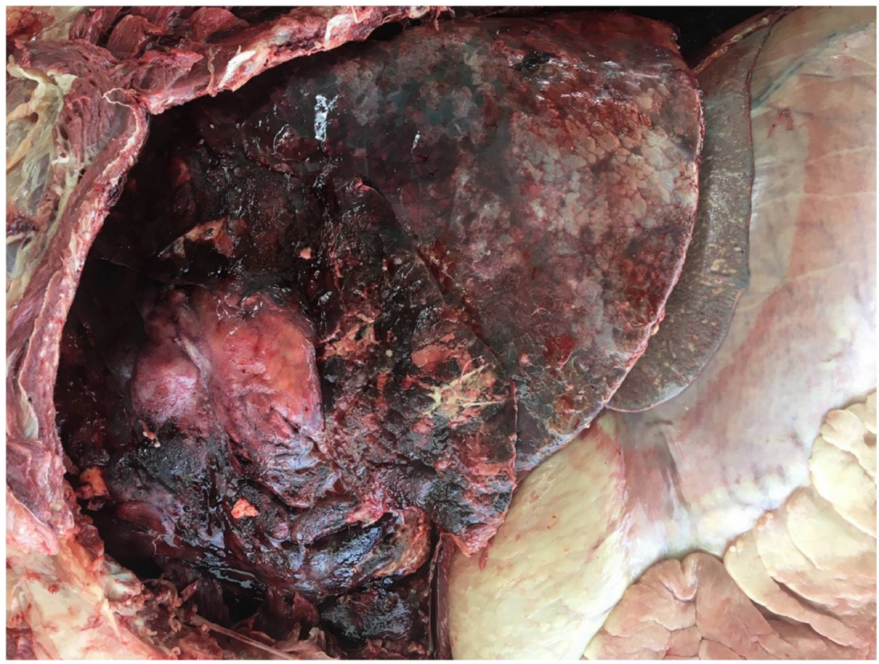
Figure 2. Left lung. Pleuritis and bronchopneumonia. Cranial and cardiac lobes appear congested and covered by discrete amounts of